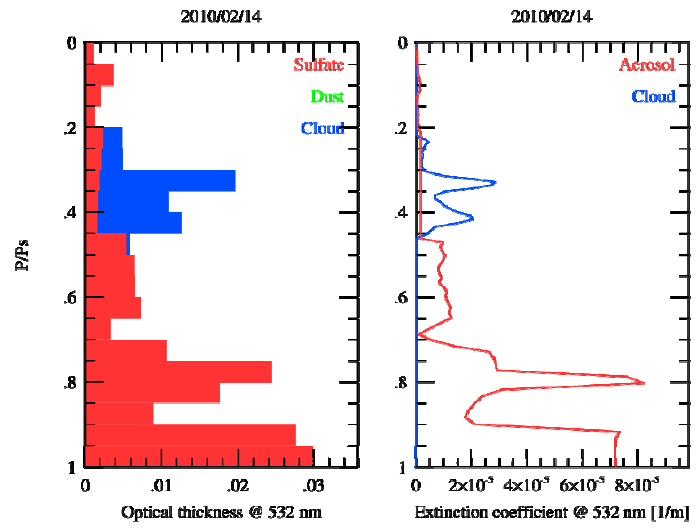
Fig. 3. Vertical profiles of the optical thicknesses (left panel) and extinction coefficients (right panel) of sulfate and cirrus cloud particles at 532nm on 14 February 2010. The vertical scale is pressure normalized to surface pressure. The values of 0.5 and 0.1 correspond to altitudes Fig. 3. of about 5.5 and 16km, respectively.